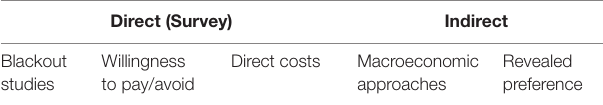
TABLe 3 | Overview of different voLL measurement techniques. TABLe 4 | Pros and cons of direct (survey) measurement